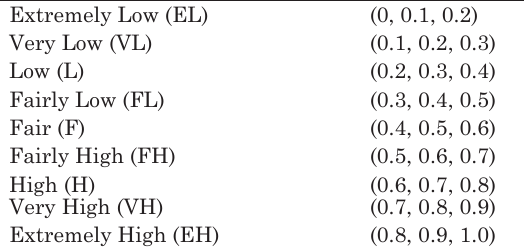
table 4. The natural language expression